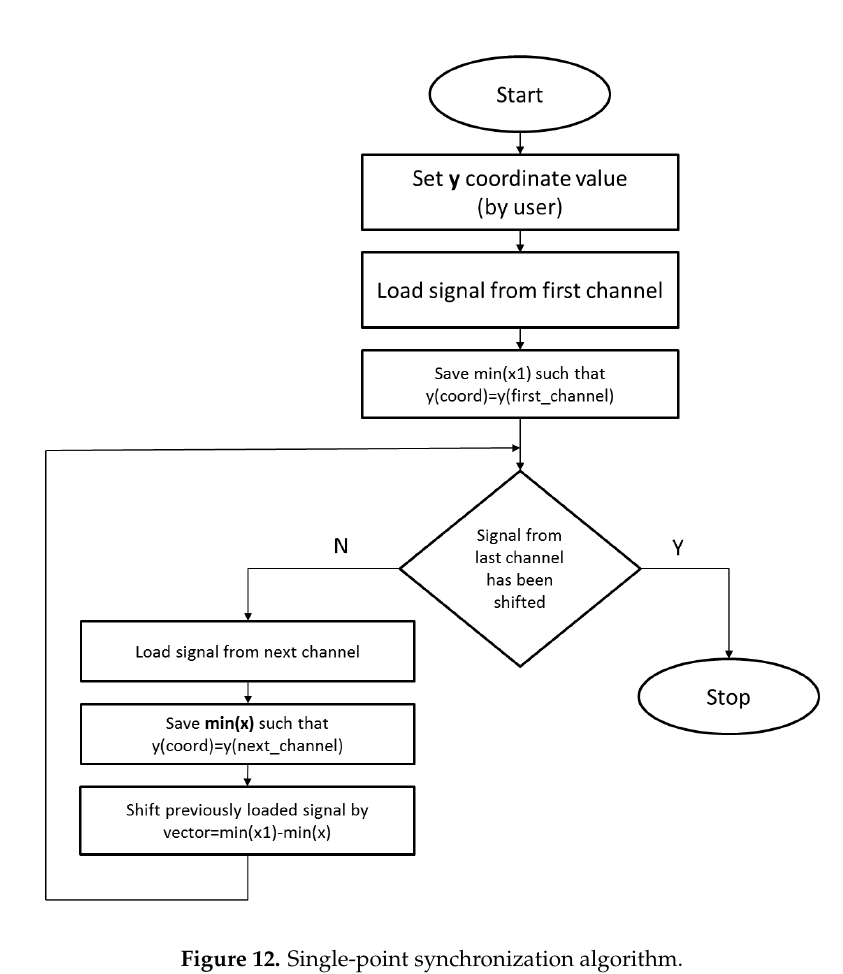
Figure 12. Single-point synchronization algorithm.